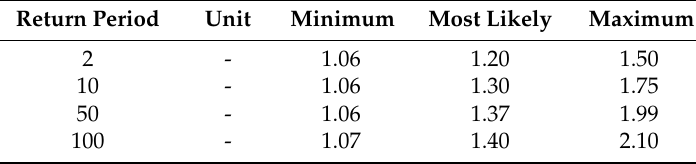
Table 1. Uncertainty ranges for climate factors for the different return periods, all for a planning horizon of 100 years.